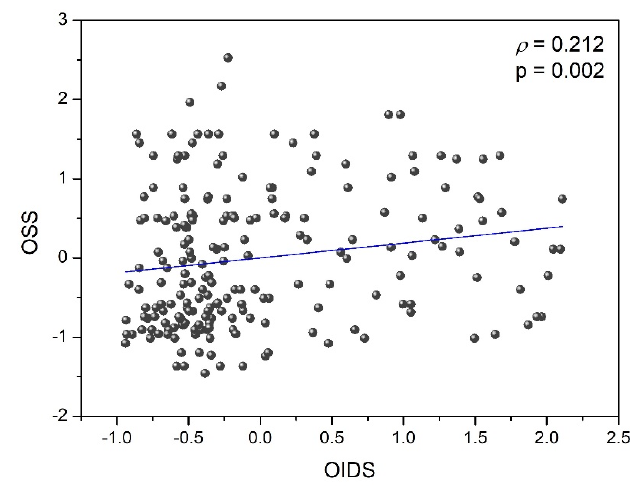
Figure 3. The overall stereoacuity score (OSS) as a function of the overall interocular difference score (OIDS) under the two experimental conditions (baseline and after alcohol